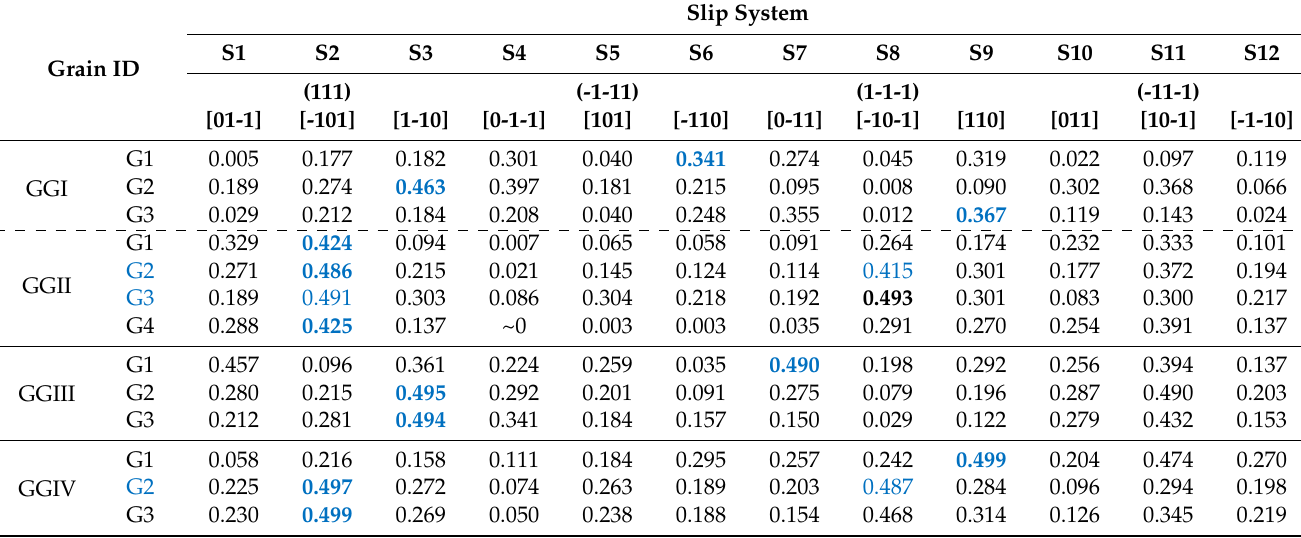
Table 1. The absolute value of Schmid factors at a strain of